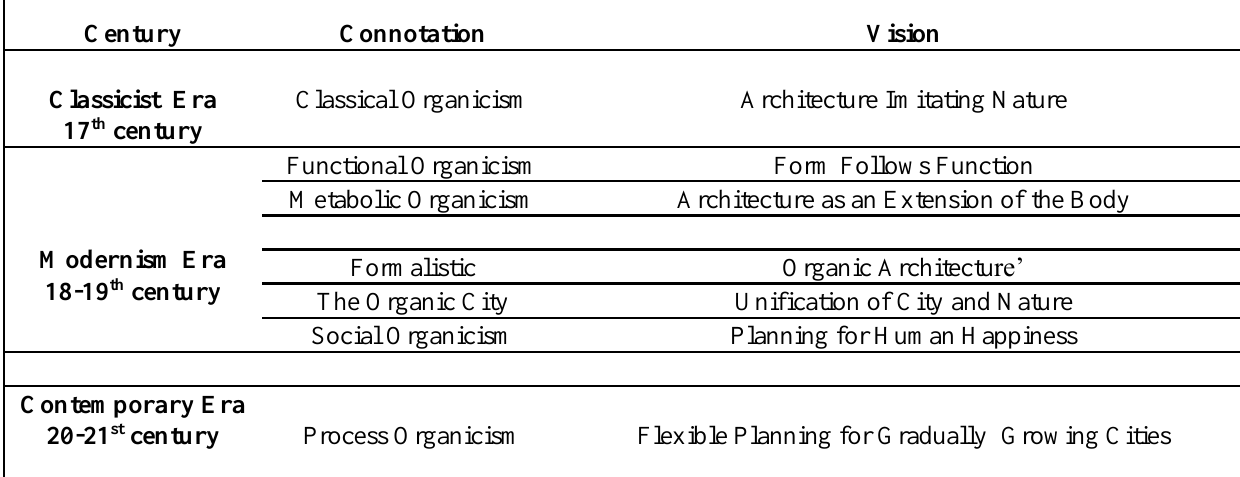
Table 2. Organicism Conceptions in relation to architecture and